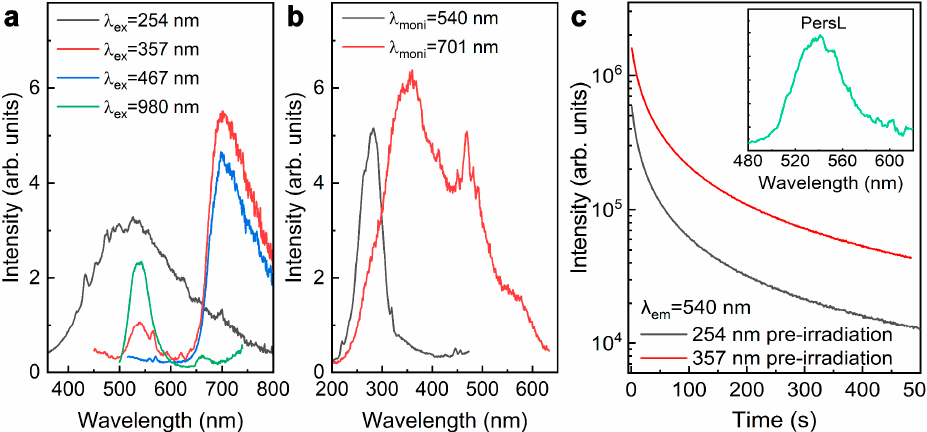
Figure 3. Excited wavelength-dependent fluorescence characteristics of Zn 3 Li 0.4 Ga 1.6 GeO 8 :Mn phosphors synthesized by hydrothermal approach. ( a ) PL spectra under various selective excitation and PSL upon 980 nm laser diode (0.5 W) irradiation; ( b ) PLE spectra (monitored at 540 or 701 nm); ( c ) PersL decay curves (monitoring at 540 nm) after irradiation by using 254 nm or 357 nm light for 5 min, the inset is the PersL emission spectrum achieved at 7 s of the decay.